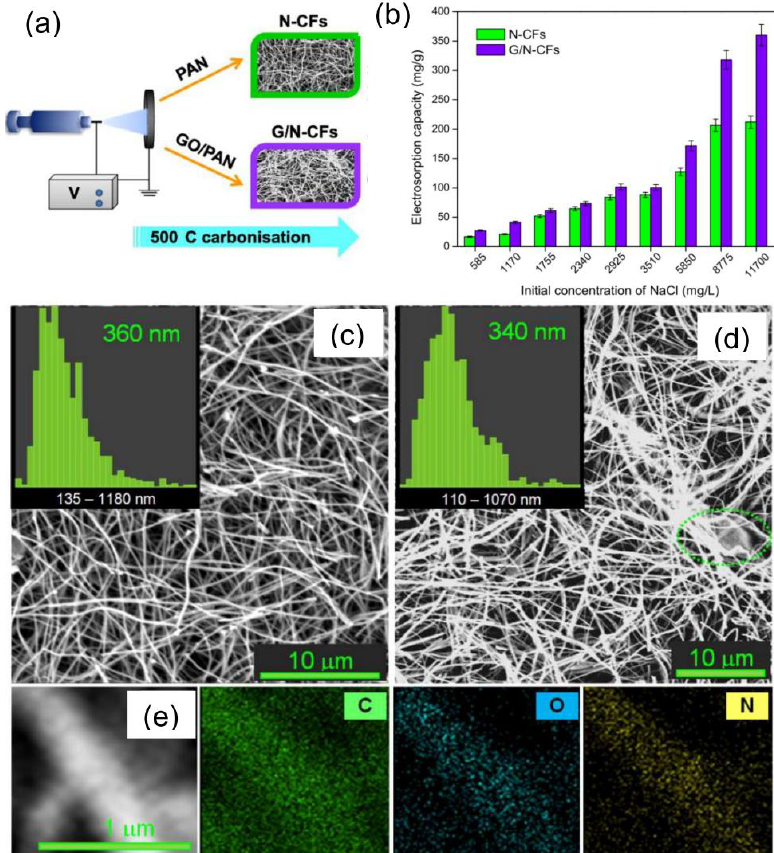
Figure 27. ( a ) Schematic illustration for the preparation of nitrogen-doped carbon fibers (N-CFs) and graphene-enriched nitrogen-doped carbon fibers (G/N-CFs). ( b ) Electrosorption capacity of the N-CFs and G/N-CFs electrodes at different NaCl concentrations. ( c , d ) Morphology, as resulting from SEM analysis, and ( e ) elemental composition of the G/N-CFs. SEM images refer to (c) N-CFs and (d) G/N-CFs. Insets: fiber diameter distributions (reproduced from reference [55] with permission. Copyright 2017, Elsevier).